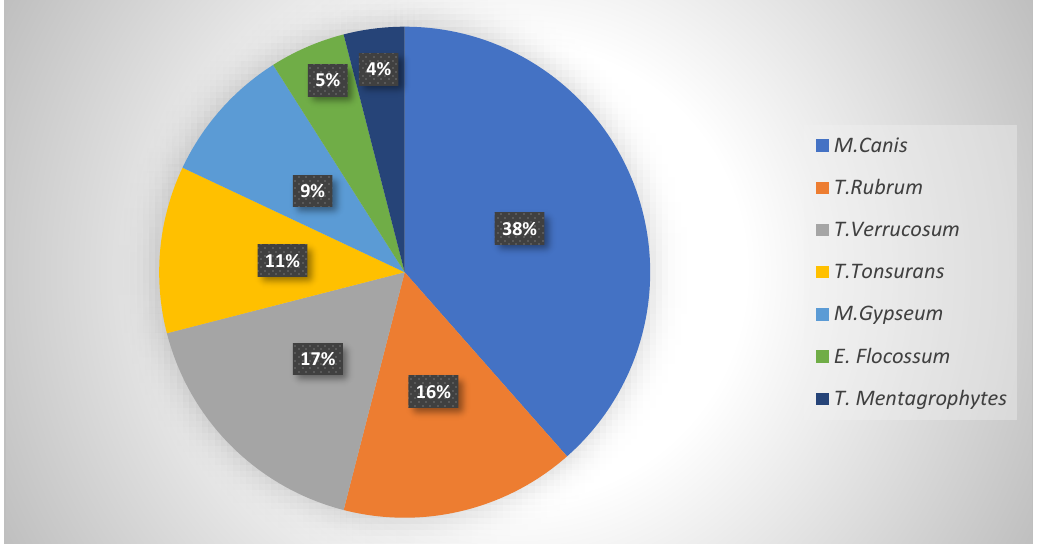
Figure 1. Percentage distribution of dermatophyte species (Total number=78).